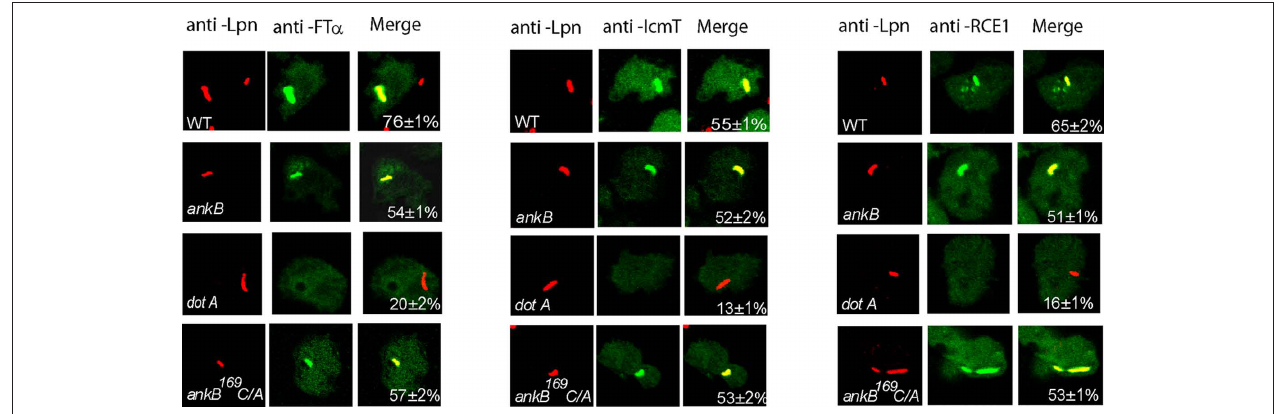
FIguRe 8 | Dot/Icm-dependent recruitment of the three farnesylation enzymes FT α , RCe-1, and Icmt to the LCV within D. discoideum . D. discoideum were infected with various strains for 1 h. At 2 h after infection, the cells were labeled with anti-Lpn antibodies (red) and anti-FT α , anti-RCE-1, or